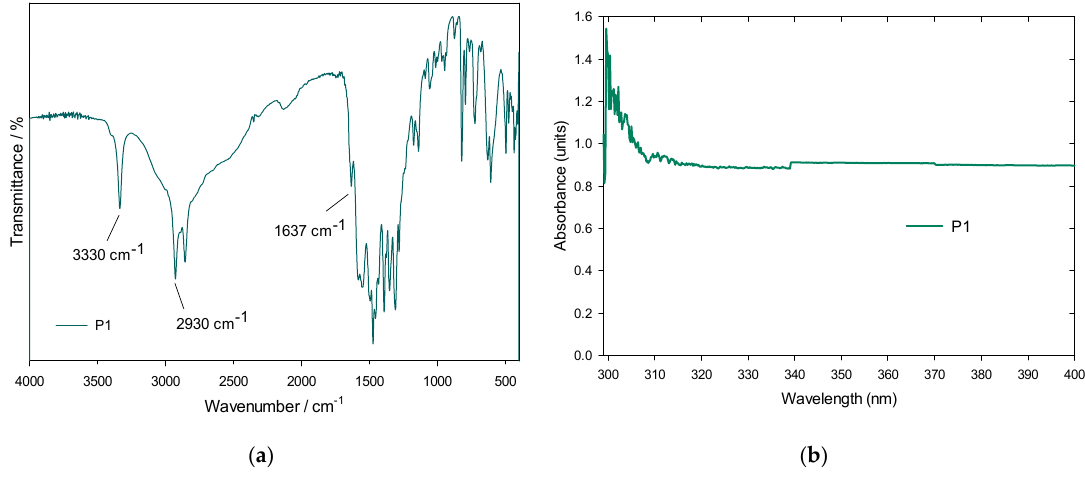
Figure 12. ( a ) IR spectra and ( b ) UV-Vis spectra of Figure 12. (a) IR spectra and (b) UV-Vis spectra of P1 .